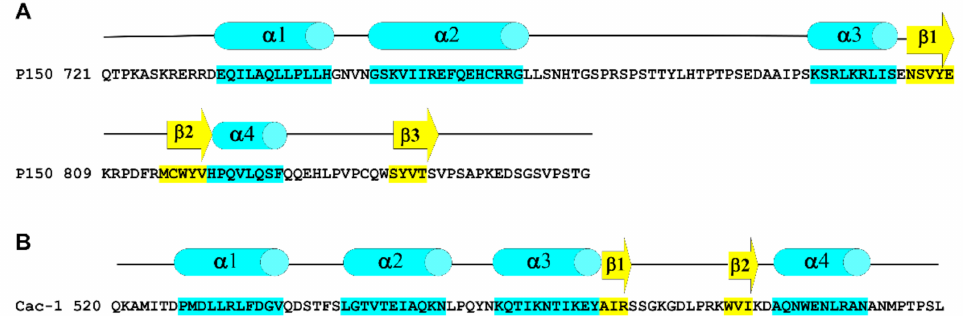
Figure 5. Schematic representation of P150 and Cac-1 WHD secondary structure. Helices and strands of P150 WHD ( A ) have been predicted by the PHD program, whereas those of Cac-1 WHD ( B ) have been calculated with Whatcheck [78] using the crystallographic coordinates (PDB accession code 5JBM) [48]. Helices and strands are represented as cyan cylinders and yellow arrows, respectively. Primary sequences are also